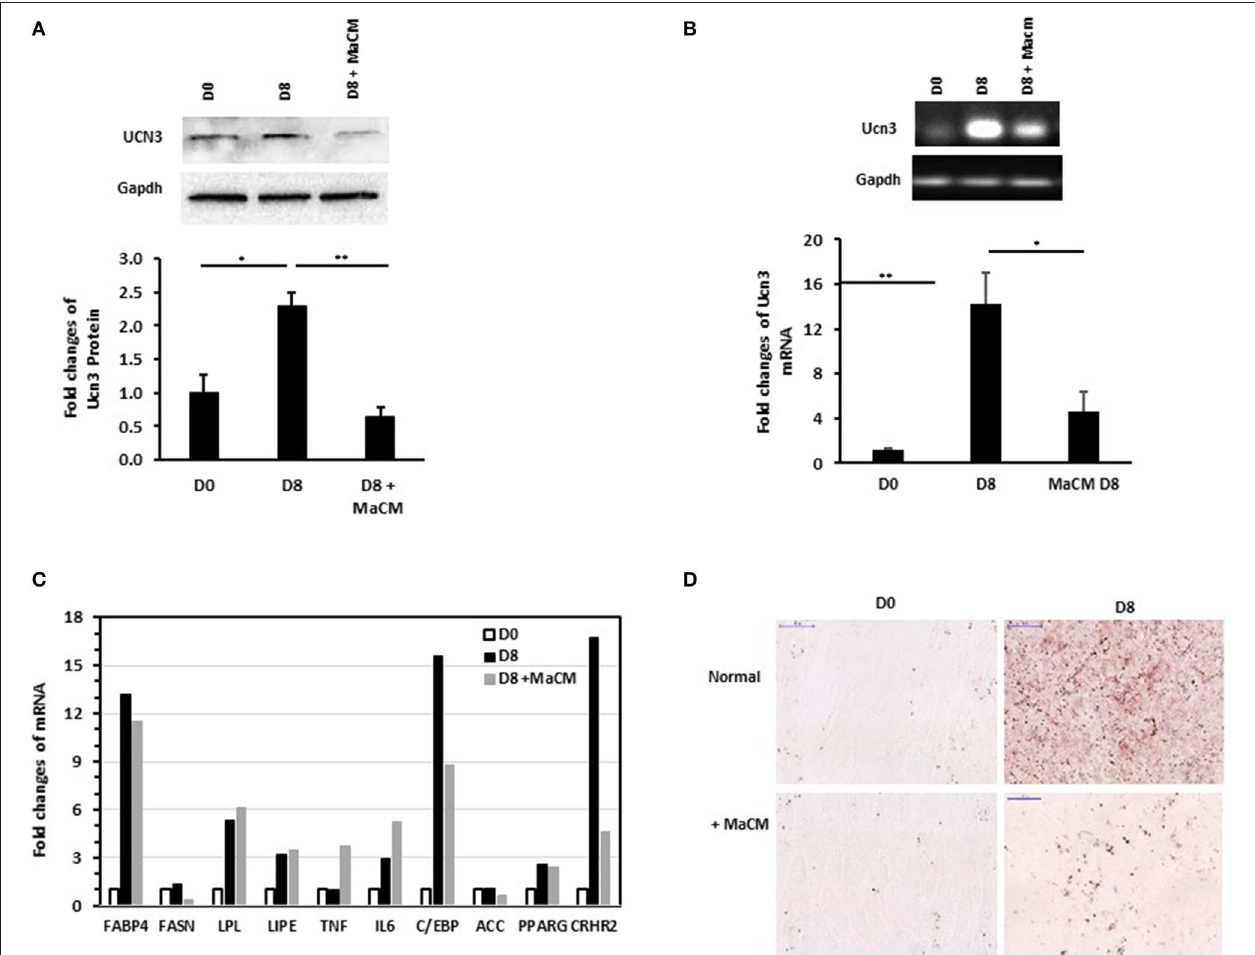
FIGURE 2 | Expression levels of Ucn3 before and after differentiation of 3T3 preadipocytes. Protein (A) and mRNA (B,C) levels were measured by Western blot and quantitative real-time PCR, respectively, using 3T3-L1 preadipocytes (D0), adipocytes differentiated for 8 days (D8) with and without macrophage conditioned media (MaCM). Data are presented as fold changes in differentiated adipocytes compared with the findings in preadipocytes from 3 independent experiments . (D) Representative images for Oil Red O staining illustrating differentiation under normal and MaCM conditions. Images were taken at magnification of 40X. * p < 0.05 and ** p <